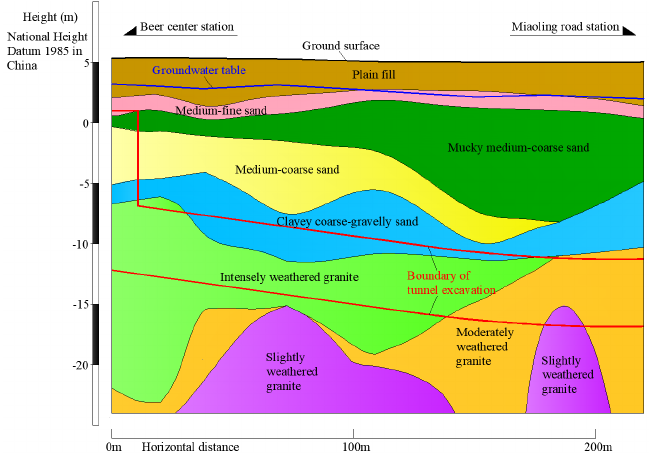
Figure 8. Geological longitudinal profile of the tunnel. Table 2. Strength parameters of stratum in upper and lower semi-section of tunnel face.